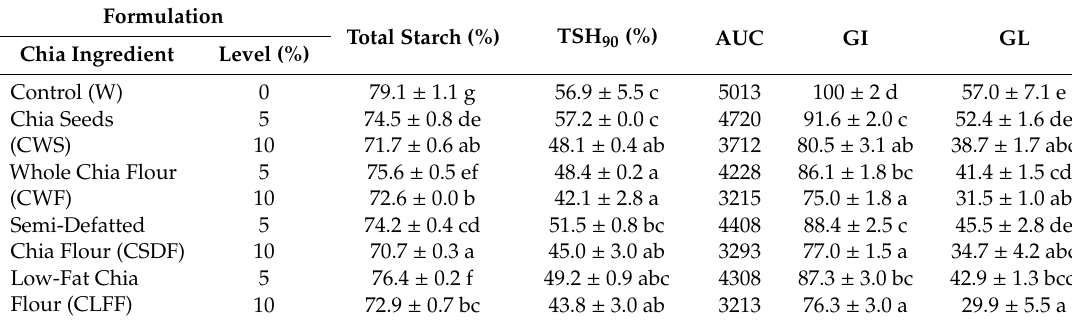
Table 5. E ff ect of chia by-products in bread formulation on in vitro glycemic index estimation a .